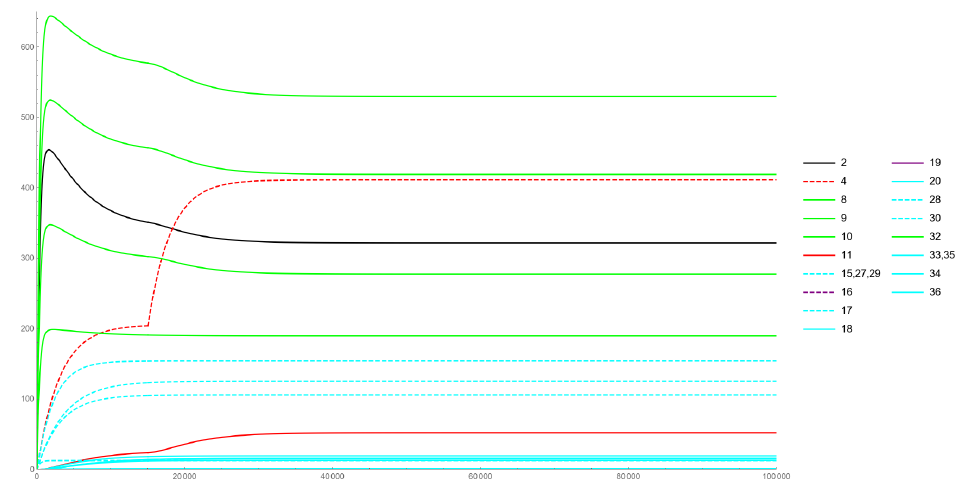
Figure 6. Increased Expression